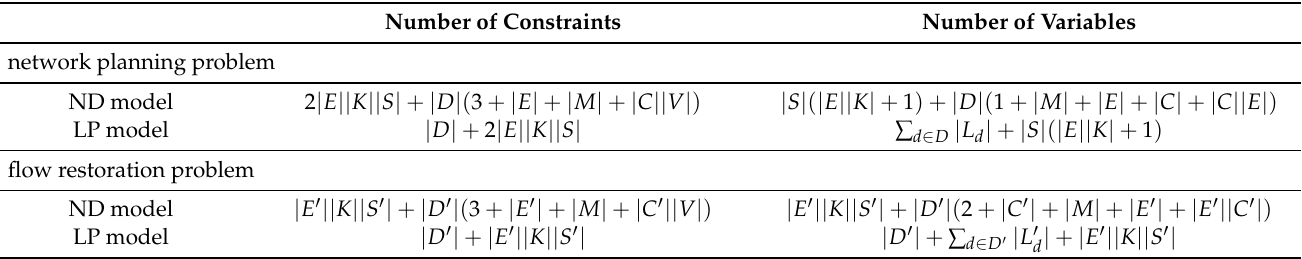
Table 2. Complexity of the proposed ILP models: the number of constraints and variables as a function of the problem char- acteristics.